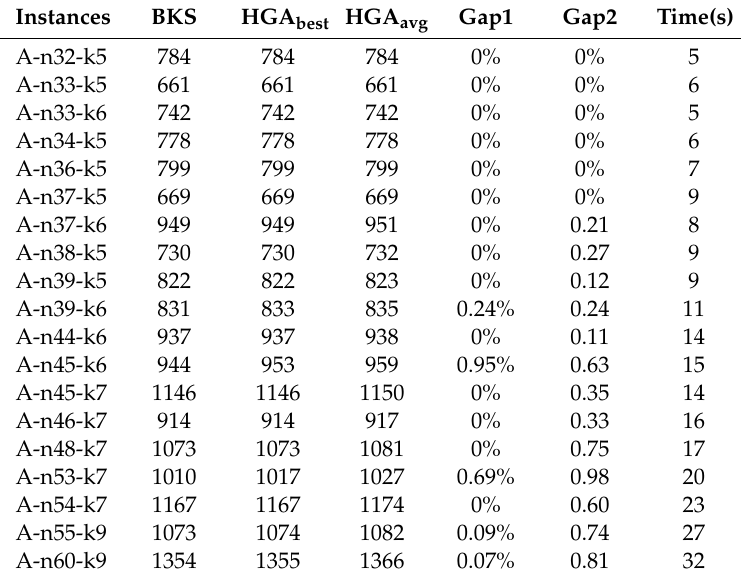
Table 4. The results of HGA in solving VRP benchmark